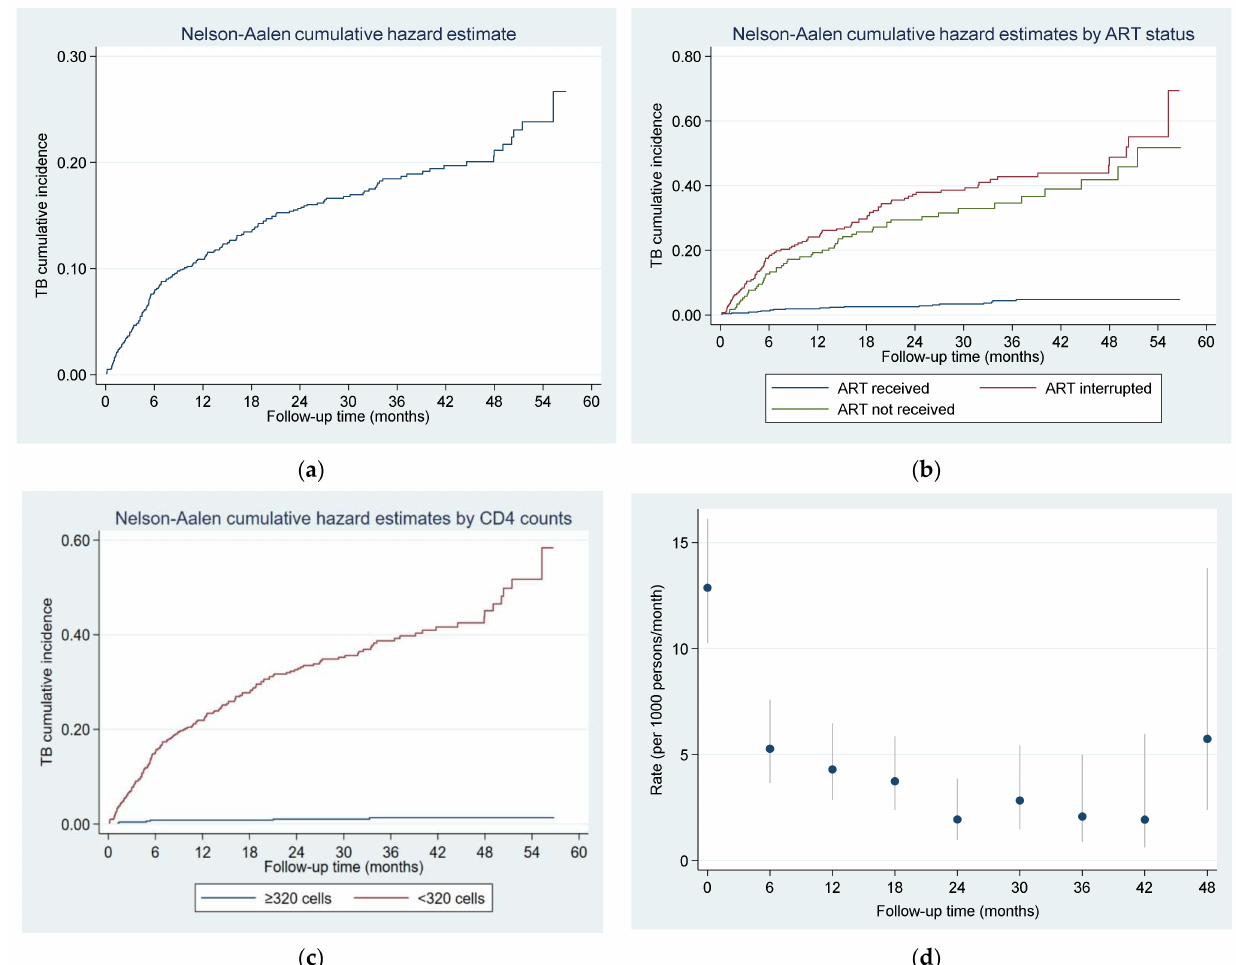
Figure 1. ( a ) Nelson–Alen cumulative hazard estimates for developing TB among people newly diagnosed with HIV from 2015 to 2017 in Tashkent, Uzbekistan. ( b ) Nelson–Alen cumulative hazard estimates for developing TB among people newly diagnosed with HIV from 2015 to 2017, by ART status. ( c ). Nelson–Alen cumulative hazard estimates for developing TB among people newly diagnosed with HIV from 2015 to 2017 in Tashkent, Uzbekistan, by CD4 cell count. ( d ) Six-monthly average TB incidence rates among 1010 people newly diagnosed with HIV, over a 5-year follow-up period; vertical lines indicate 95% confidence interval. Incidence rate was estimated for 6-month time intervals; for example, the rate at month 6 indicates the period greater than 6 months and less than or equal to 12